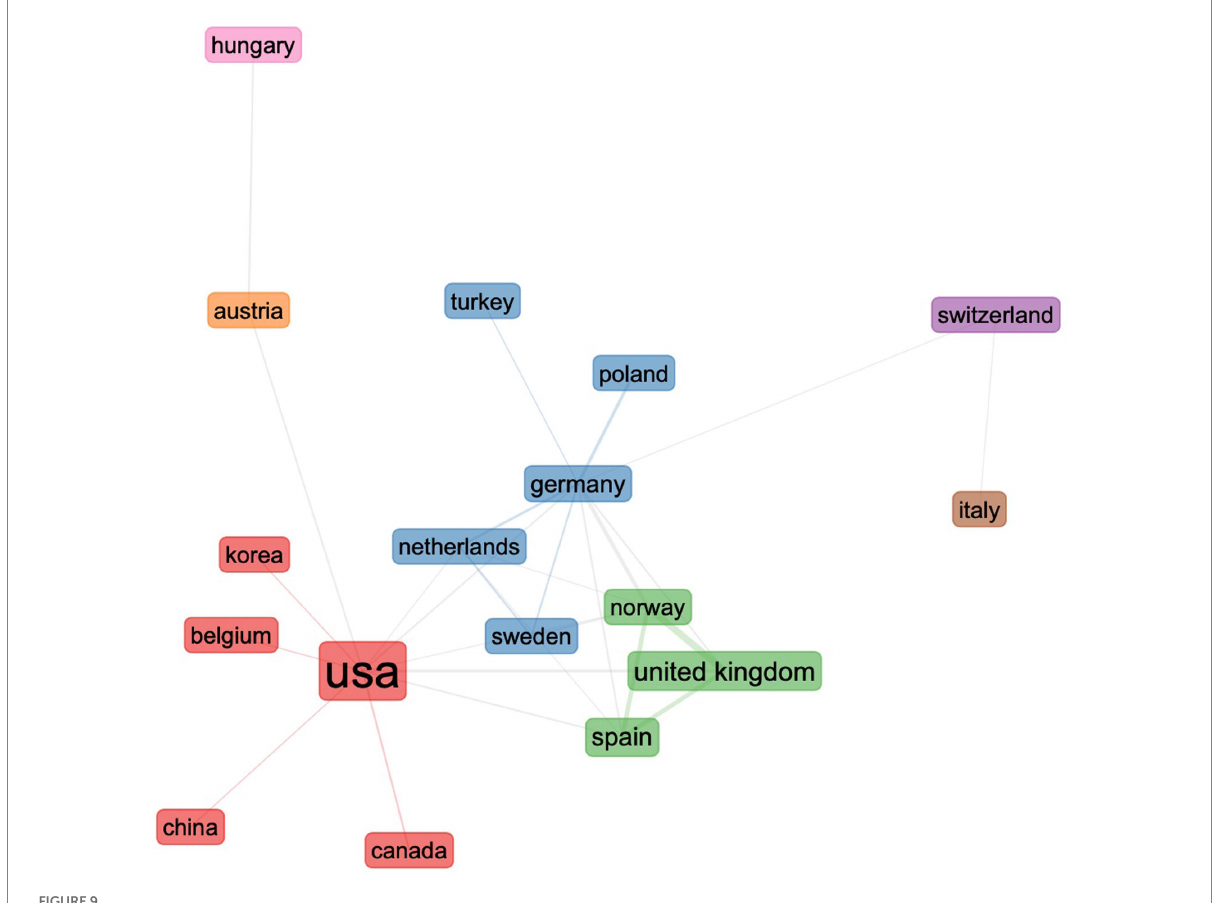
FIGURE 9 Collaboration between